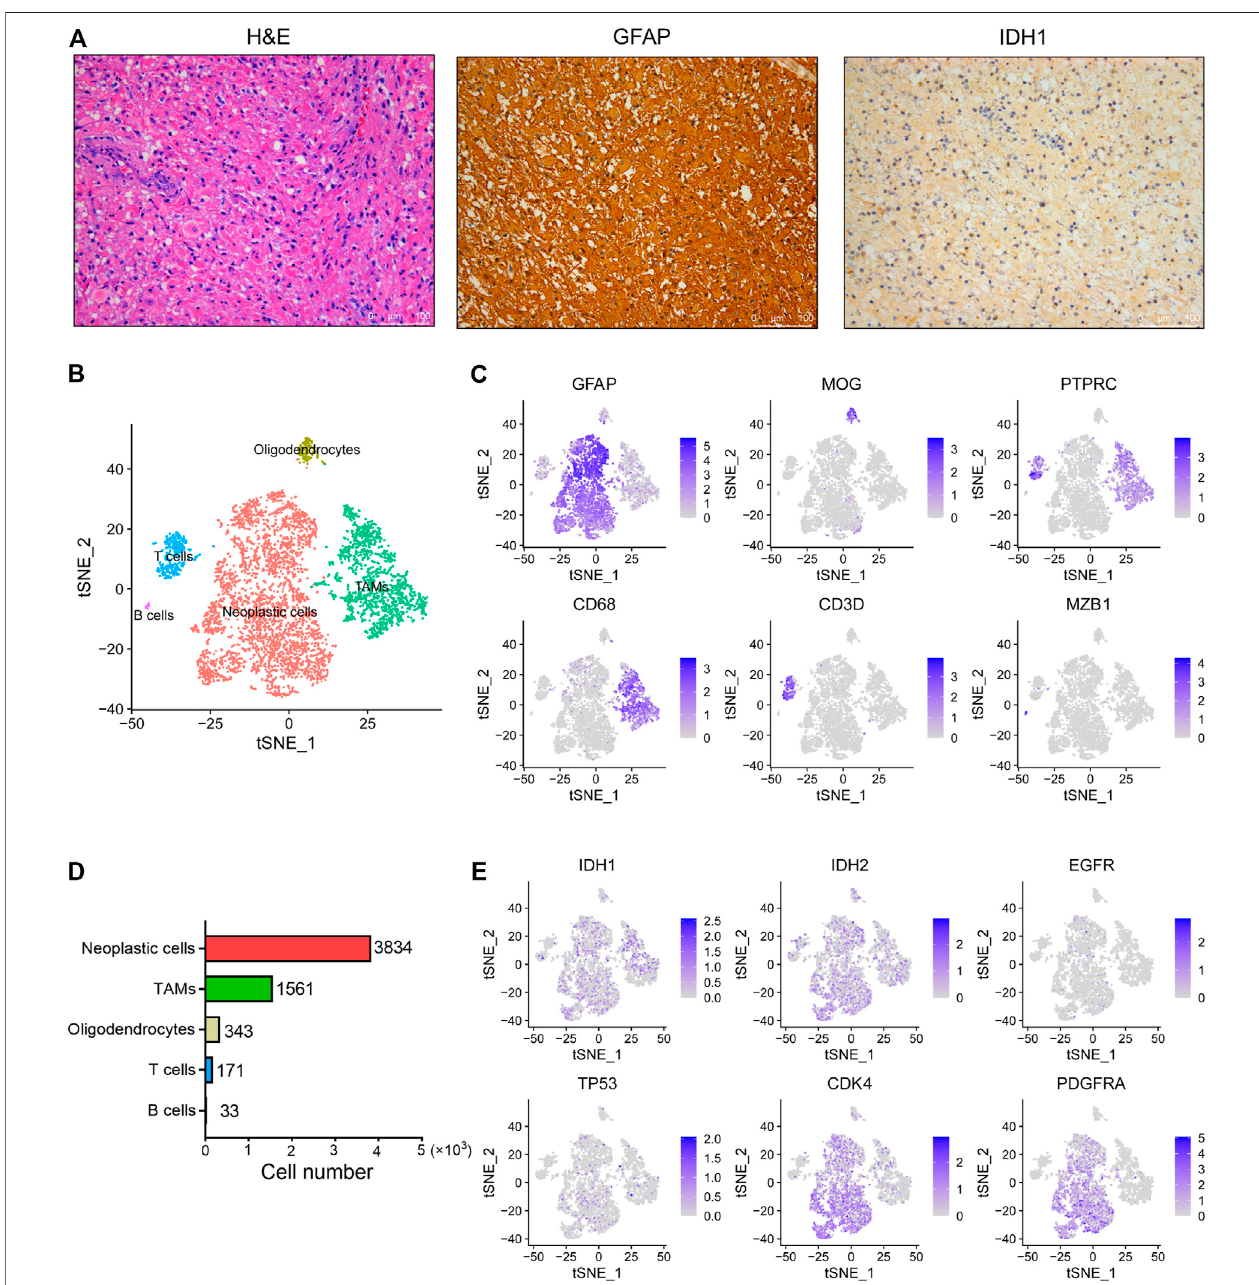
FIGURE 1 | The single-cell landscape of an IDH wild-type glioma. (A) Representative images of H&E staining and IHC staining for GFAP and IDH1 proteins in the glioma tissue. Scale bars, 100 μ M. (B) The t-SNE plot showing 5,945 single cells colored by cell types. TAMs, tumor associated macrophages. (C) The t-SNE plot showingtheGFAP,MOG,PTPRC,CD68,CD3DandMZB1expressionlevelsinindividualcells. (D) Thecellnumberofeachcelltypeinthisgliomawasdisplayed. (E) The t-SNE plot showing IDH1, IDH2, EGFR, TP53, CDK4 and PDGFRA expression levels in individual cells.